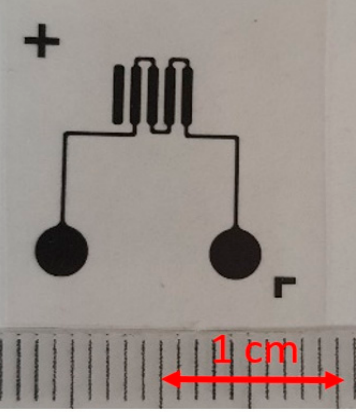
Figure 5. Polymer-based photomask.